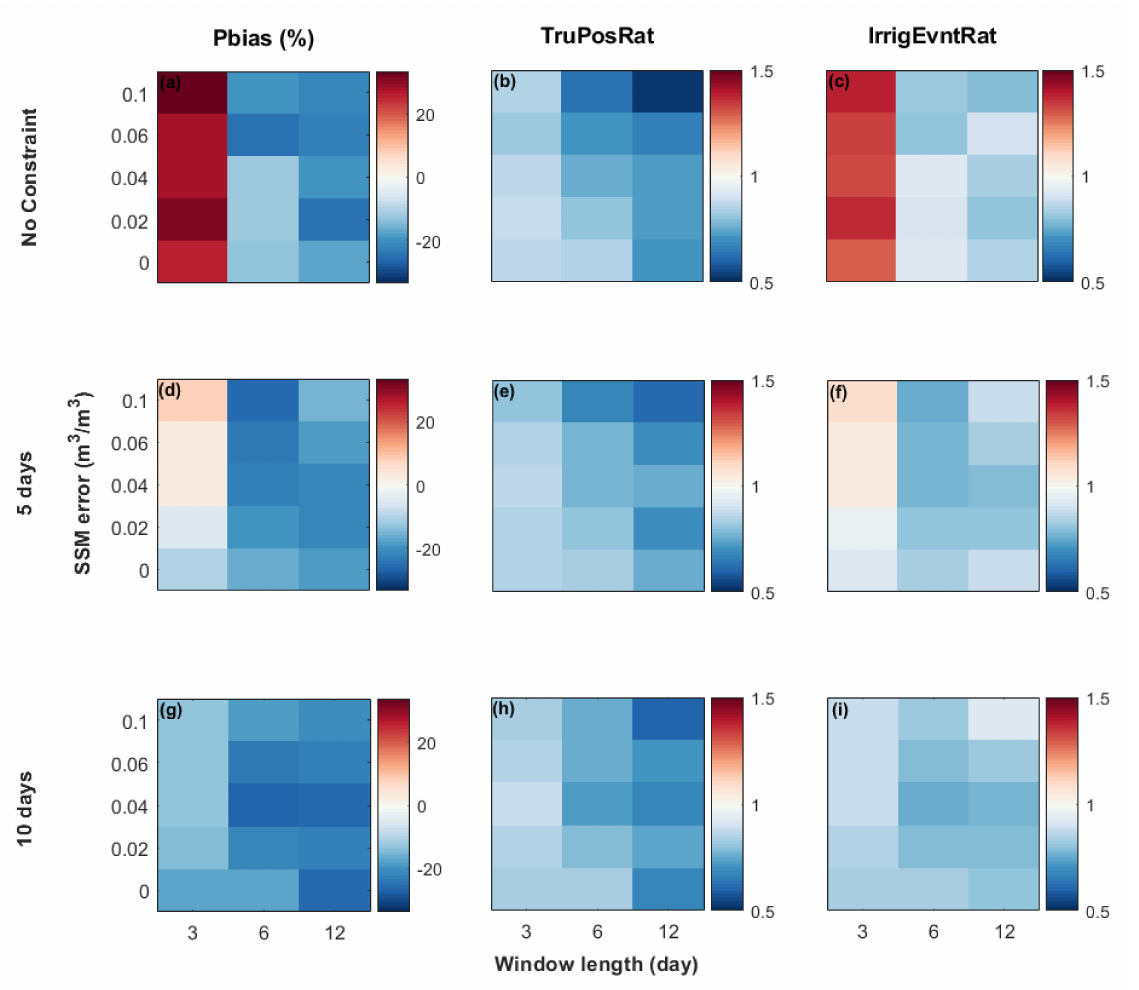
Figure 2. Statistical metrics of the synthetic experiment for the flood irrigation technique at different window length: 3-, 6- and 12-day and for different error on the surface soil moisture (SSM error). ( a – c ) are the Pbias, TruPosRat and IrrigEvntRat when there is no constraint on the irrigation timing (No Constraint), ( d – f ) when a constraint of 5 days is applied and ( g – i ) when a constraint of 10 days is